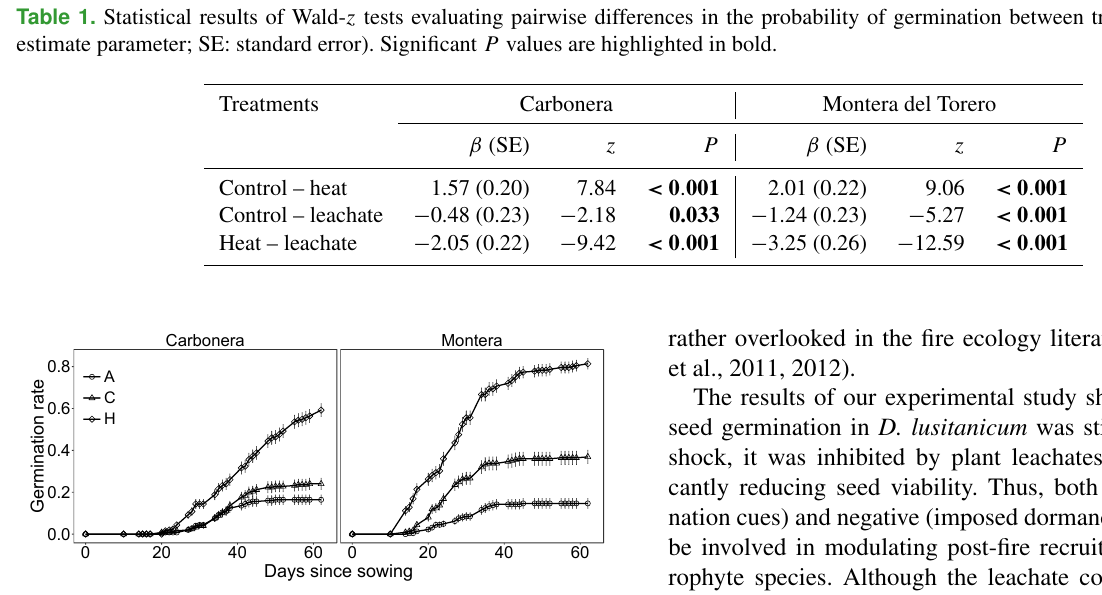
Figure 1. Germination rate of D. lusitanicum seeds through time (days since sowing) in the experimental treatments. A: allelopathy; H: heat shock; C: control. Dots are mean values ( n = 9 in Mon- tera del Torero and n = 10 in Sierra Carbonera) and error lines are SE. Different letters represent significant pair-wise differences in the probability of germination (GLMM, Wald- z test, P < 0 . 05, Ta- ble